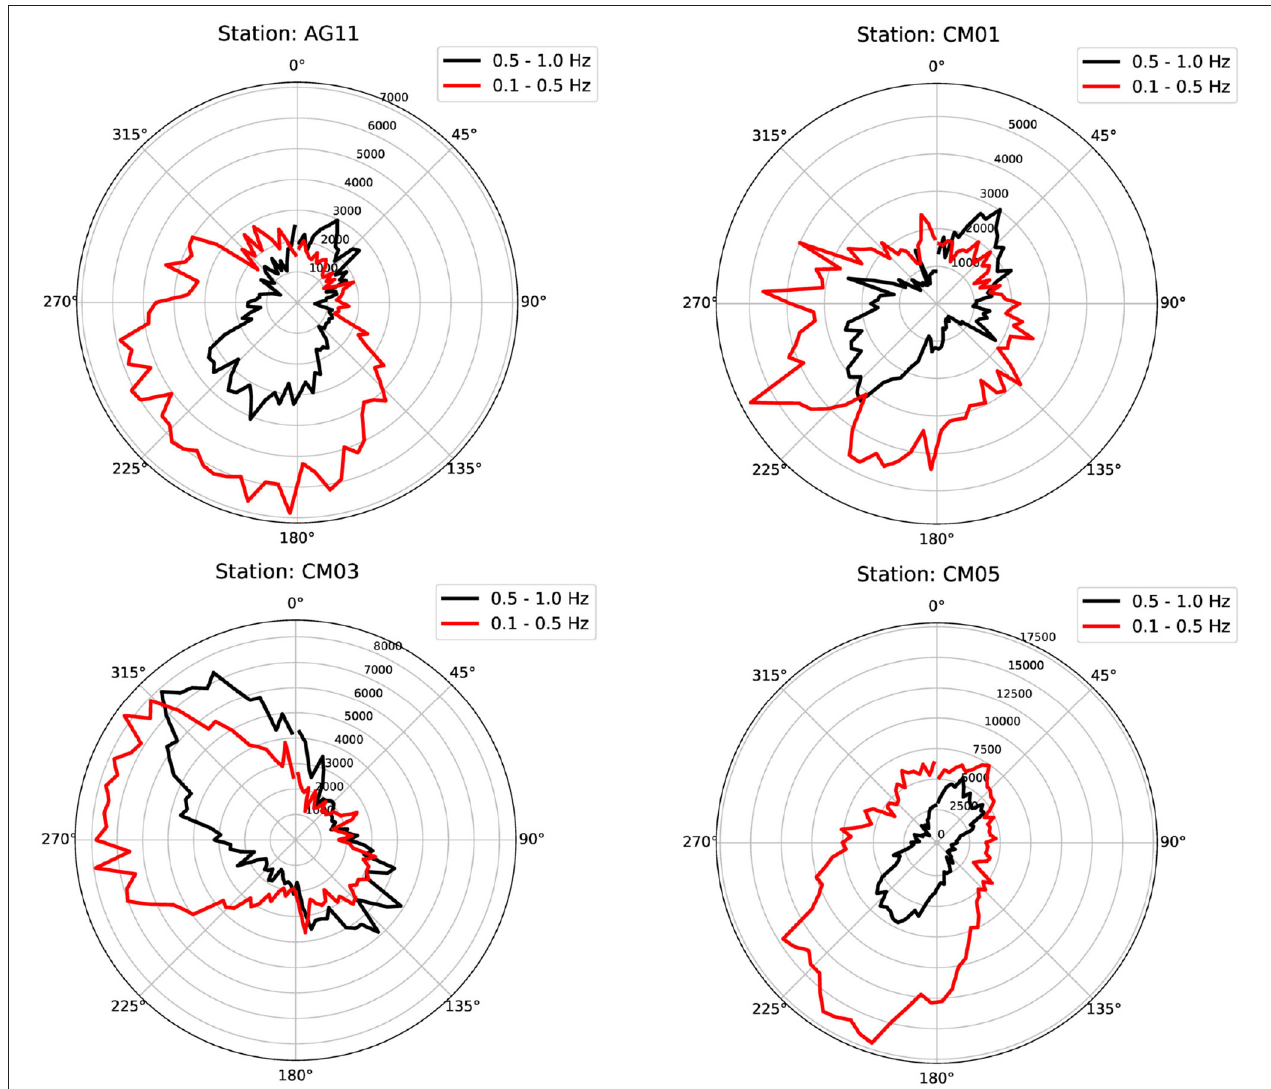
FIGURE 4 | Azimuthal source distribution in all the period for 4 sample stations measured using the DOP-E approach (Berbellini et al., 2019) in two different frequency bands, 0.5–1.0 Hz (black line) and 0.1–0.5 Hz (red